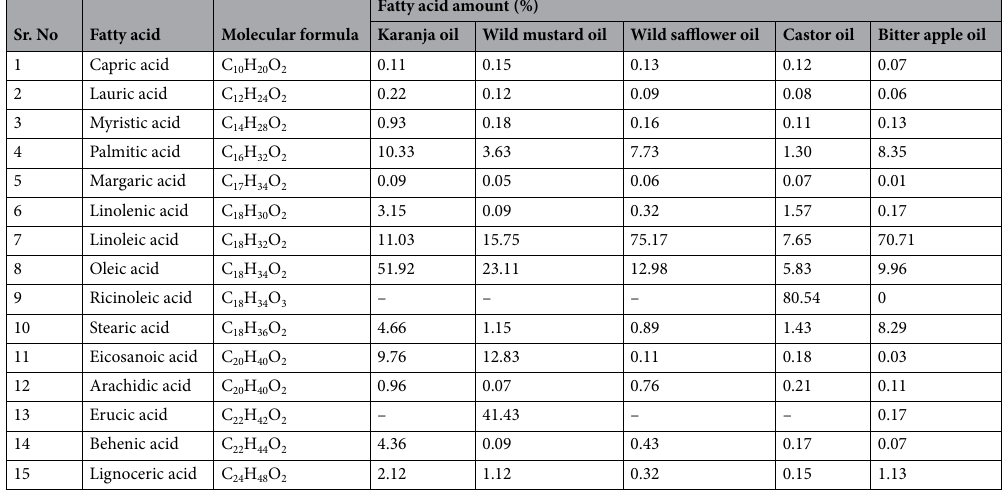
Table 10. The major fatty acid present in karanja 46 , wild mustard 23 , wild safflower 47 , castor 36 and bitter apple 48 oils were oleic acid (51.92%), erucic acid (41.43%), linoleic acid (75.17%), ricinoleic acid (80.54%) and linoleic acid (70.71%), respectively. The results obtained clearly show that the feedstock oils used in the present study have significantly different fatty acid compositions.